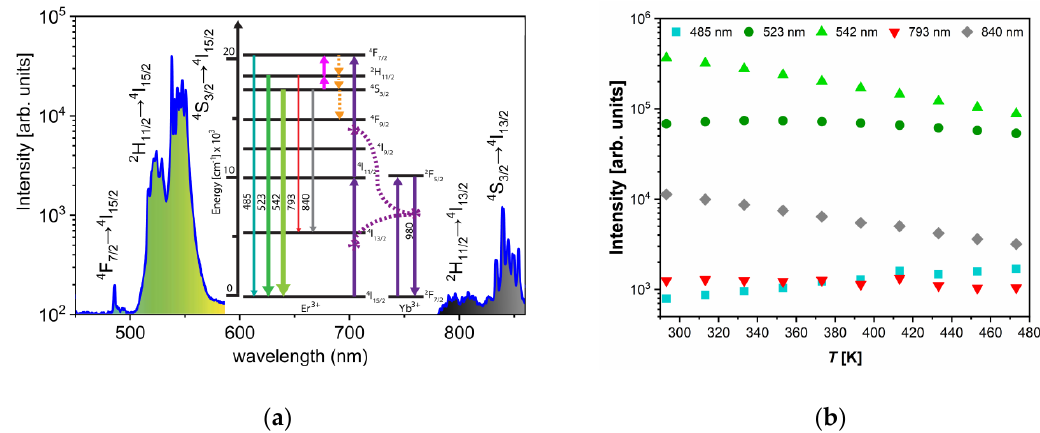
Figure 2. ( a ) Upconversion emission spectra of YF 3 :Yb 3 + / Er 3 + excited by 980 nm (150 mW laser radiation) which show the excitation mechanisms and emission bands and electronic transitions of interest to luminescence thermometry; the thickness and color of emission arrows indicate the strength and color of upconversion emissions, respectively (the part of emission spectra between 600 and 750 nm where emission band due to 4 F 9 / 2 → 4 I 15 / 2 transition occurs is omitted since it is not of interest for this study); ( b ) temperature dependences of intensities of Er 3 + upconversion emissions: 485 nm (turquoise square – 4 F 7 / 2 → 4 I 15 / 2 transition), 523 nm (dark green circle – 2 H 11 / 2 → 4 I 15 / 2 ), 542 nm (light green up-triangle – 4 S 3 / 2 → 4 I 15 / 2 ), 793 nm (red down-triangle – 2 H 11 / 2 → 4 I 13 / 2 ), and 840 nm (gray diamond – 4 S 3 / 2 → 4 I 13 / 2